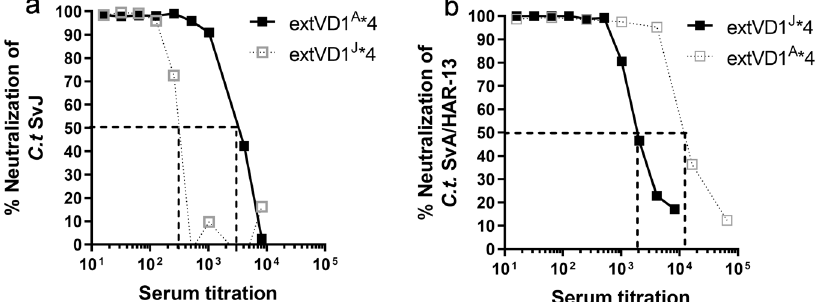
Fig. 3 Cross-neutralization of SvA and SvJ with extVD1 J *4 and extVD1 A *4-speci fi c sera. A/J mice were immunized with either 10 µg of extVD1 A *4/CAF01 or extVD1 J *4/CAF01. Sera were isolated 3 weeks post third s.c. vaccination and pooled for each group ( n = 5 – 6), titrated, mixed with a fi xed concentration of either C.t . SvA or SvJ, and inoculated onto a HaK cell monolayer, fi xed, and inclusions counted. Cross- neutralization of C.t . SvJ with extVD1 A *4-speci fi c serum ( a ). For comparison, the homologous neutralization using extVD1 J *4-speci fi c serum is depicted (dotted gray line). Cross-neutralization of C.t . SvA with extVD1 J *4-speci fi c serum ( b ). For comparison, the homologous neutralization using extVD1 A *4-speci fi c serum is depicted (dotted gray line). Dotted black lines indicate the reciprocal 50% neutralization titers. The individual experiments have been repeated with similar